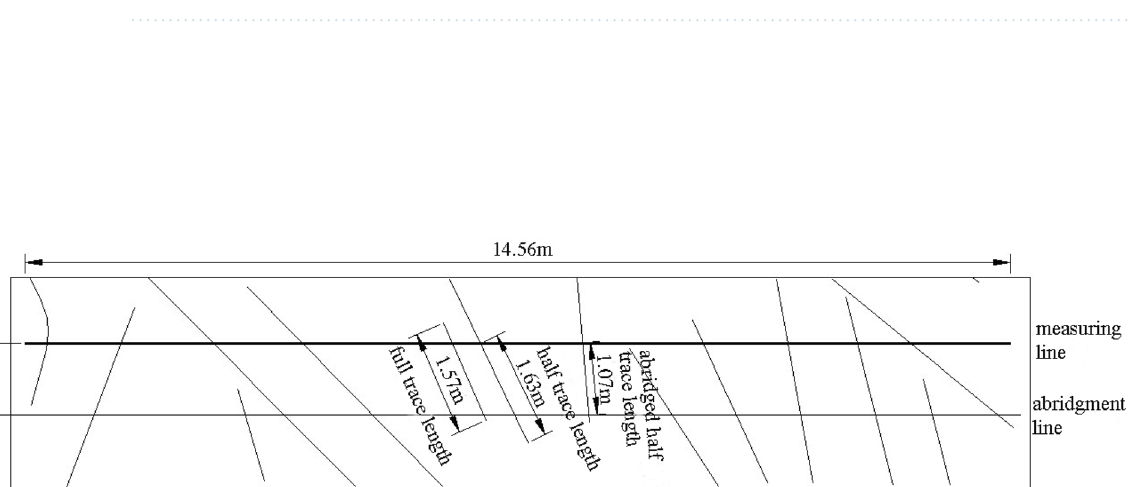
Figure 2. Distribution of rock mass structure plane 40 m away from the entrance of Suichang Gold Mine National Mine Park.